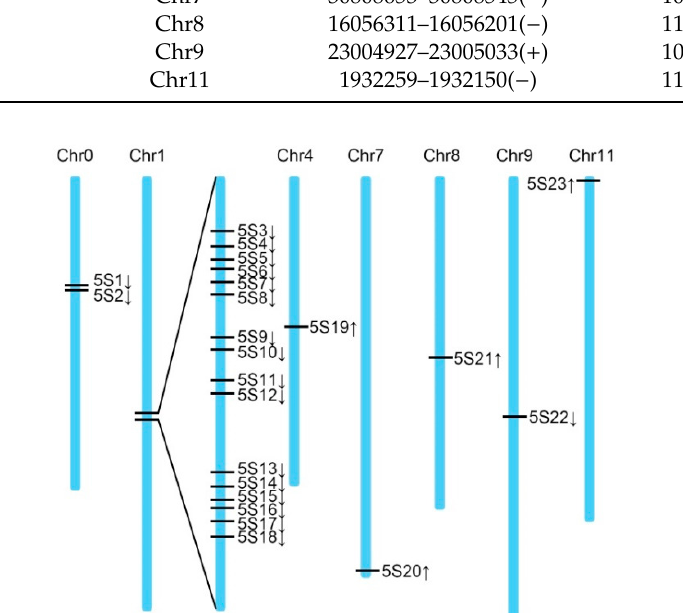
Figure 5. Distribution of 5S rDNA fragment homologous sequences on the chromosome.